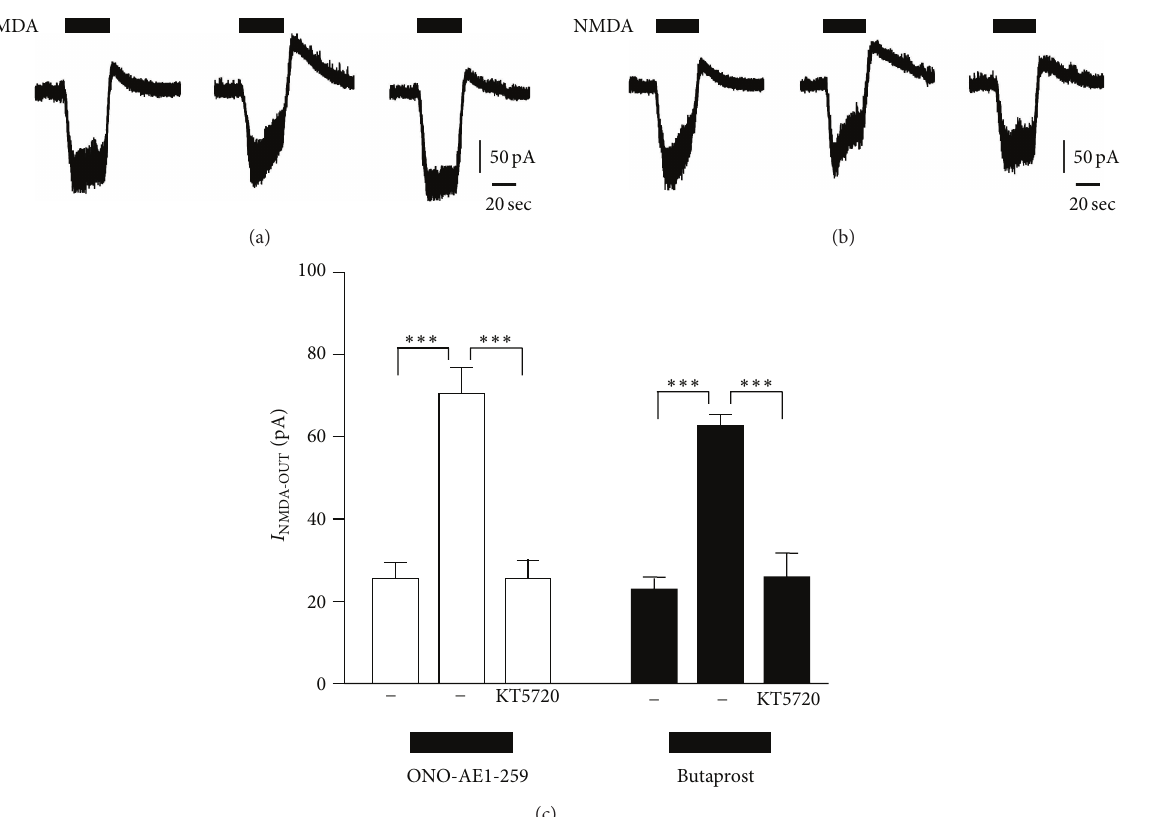
Figure 3: Inhibitory effects of PKA inhibitor on EP2 receptor agonists-induced potentiation of 𝐼 ONO-AE1-259 (10 𝜇 M) or butaprost- (10 𝜇 M) induced potentiation of 𝐼 currents. The columns and bars represent the mean ± SEM ( 𝑛 = 3 cells). Asterisks indicate a significant difference between the values ( ∗∗∗ 𝑃 < 0.001 , unpaired t -test). Calibration bars are 50 pA and 20